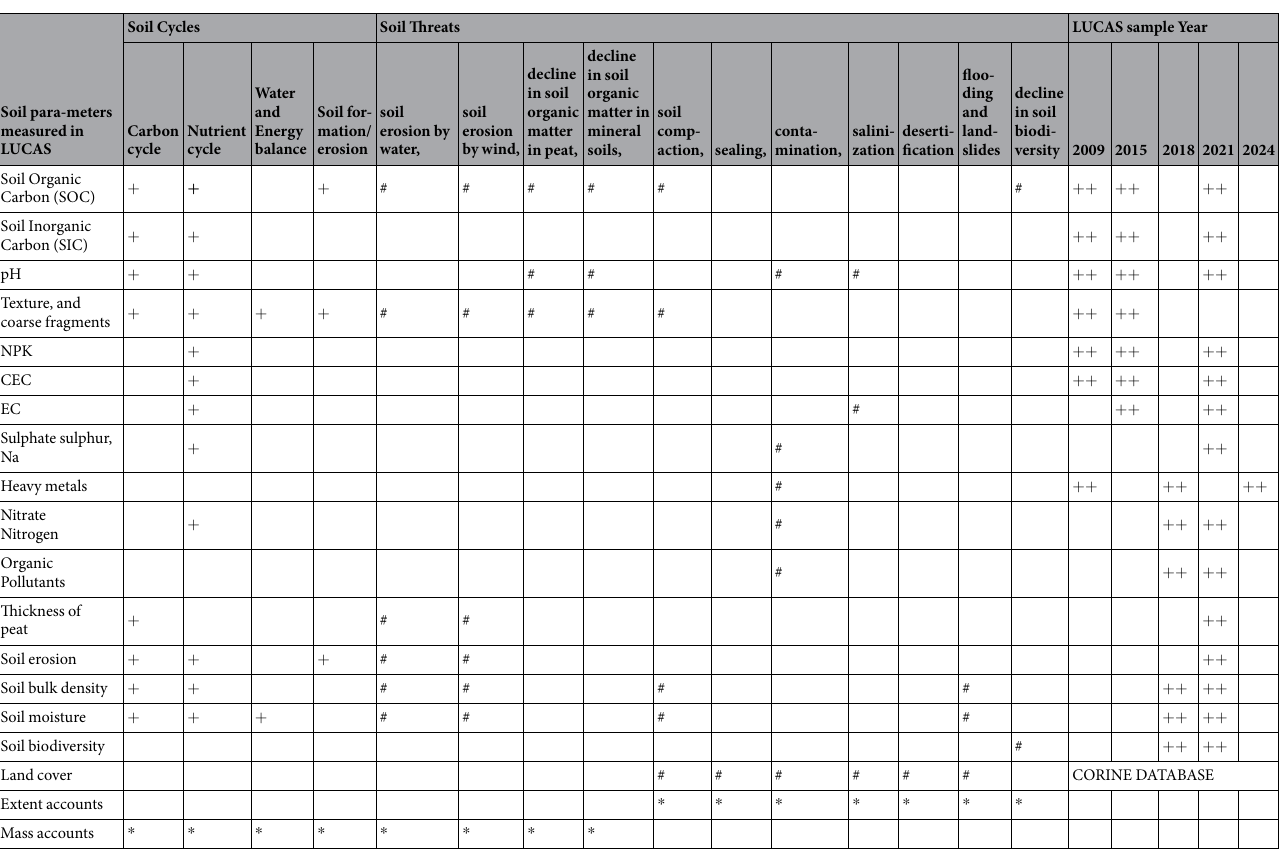
Table 2. LUCAS soil measurements and their relation to primary soil cycles, threats and when they are to be sampled; modified from ref.